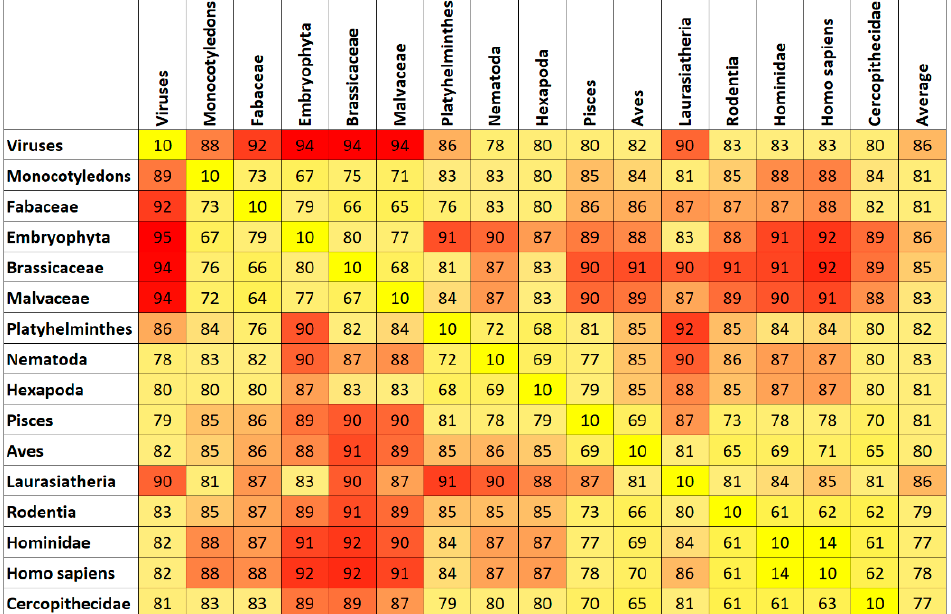
Figure 6. Difference between k-mer first–last distance and k-mers only. Yellow shades indicate better performance for k-mer first–last distance, while red shades indicate higher average classifi- cation accuracy for k-mers. For comparison, we used other features, including structural features such as the number of bulges [32], thermodynamic ones such as minimum free energy [33], and com- binations such as the triplet feature [34] consisting of one nucleotide and its adjacent fold- ing structure. The same procedure that was used for the establishment of k-mer and k- mer distance models was employed. The results are reported in Figure 7. The average accuracy is 0.83, just like the one for k-mer and k-mer distance features combined. The areas of Figure 7 with high accuracy are also mostly similar to the areas for k-mers (Figure 3) and the combination of k-mer features. Some of the features, especially the probabilistic ones, are computationally expensive and lead to long run times. It can be concluded that their calculation is not warranted when aiming to categorize pre-miRNAs to their species.